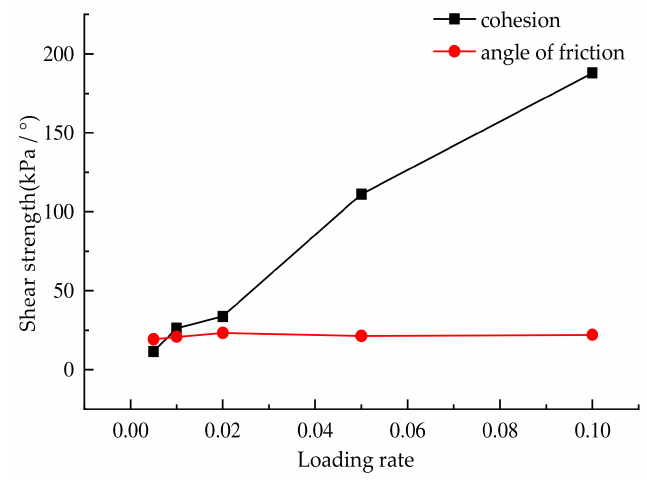
Figure 5. Influence of loading rate on shear strength.